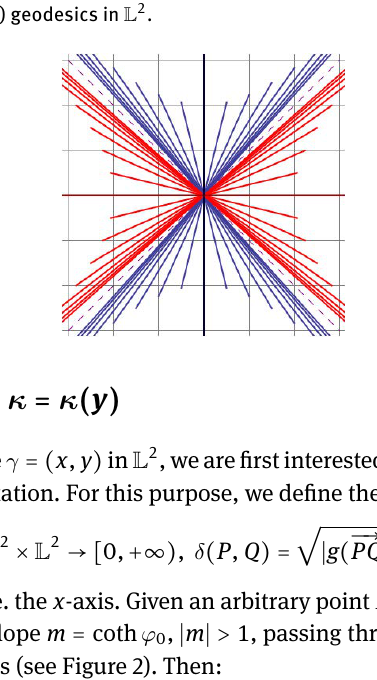
Fig. 1. Spacelike (blue) and timelike (red) geodesics in L 2 .